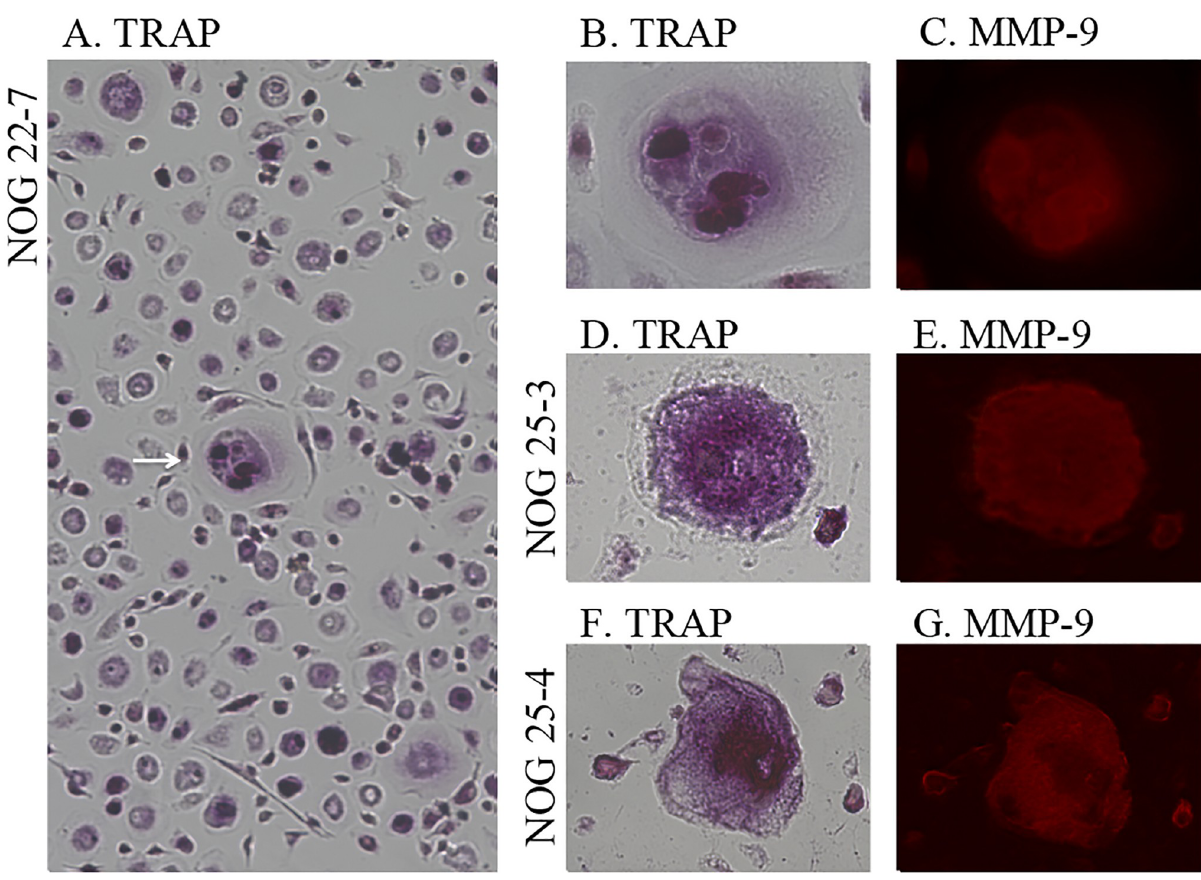
Fig 6. Cytochemistry of cultured pelvic bone marrow cells from EBV-infected hu-NOG mice in the absence of differentiation signals. (A–C) Cultured cells from an EBV-infected mouse (NOG 22–7) in glass-bottom dishes. (A and B) Cultured cells stained for TRAP. (A) Multinucleated cells were confirmed in the bone marrow (arrow). (B) The same cultured cell stained for TRAP. TRAP in the cultured multinucleated cell stained red violet. (C) The same cultured cell immunostained for human MMP-9. The TRAP-positive multinucleated cell stained red with the anti-human MMP-9 antibody. (D and E) Cultured cells from another mouse (NOG 25–3). (D) Cultured cell stained for TRAP. The multinucleated cell stained positive for TRAP. (E) The same cultured cell immunostained for human MMP-9. Multinucleated cell positive for anti-human MMP-9 antibody were stained. (F and G) Cultured cells from another mouse (NOG 25–4). (F) Cultured cell stained for TRAP. (G) The same cultured cell immunostained for human MMP-9. Original magnification, A: 100 × , others: 400 ×